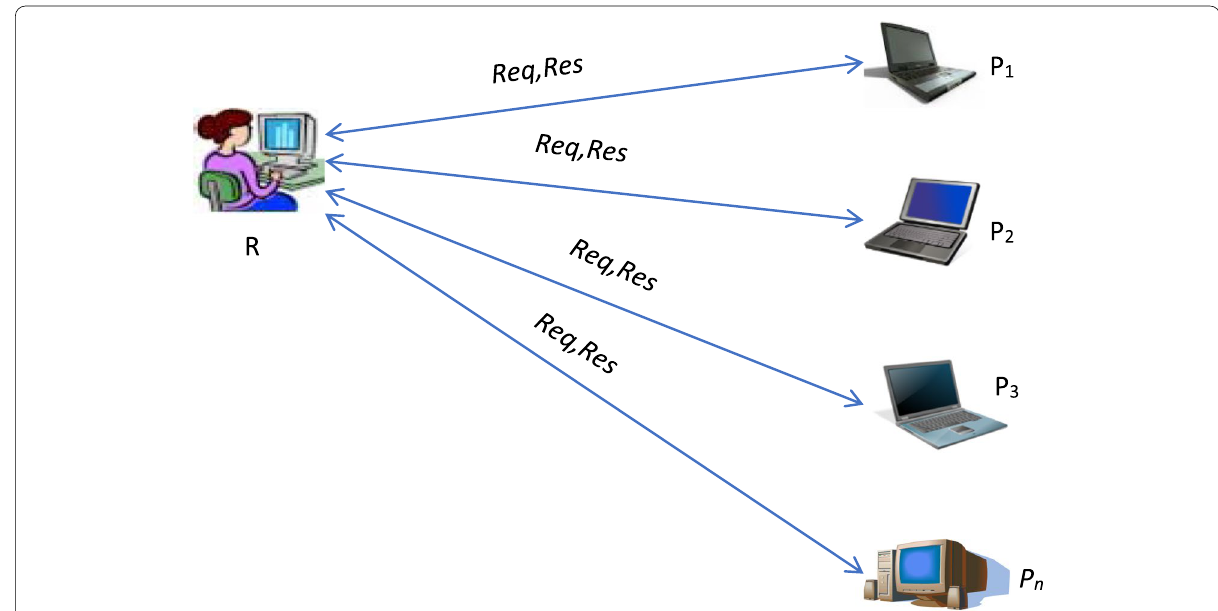
Fig. 3 Implementation of Distributed